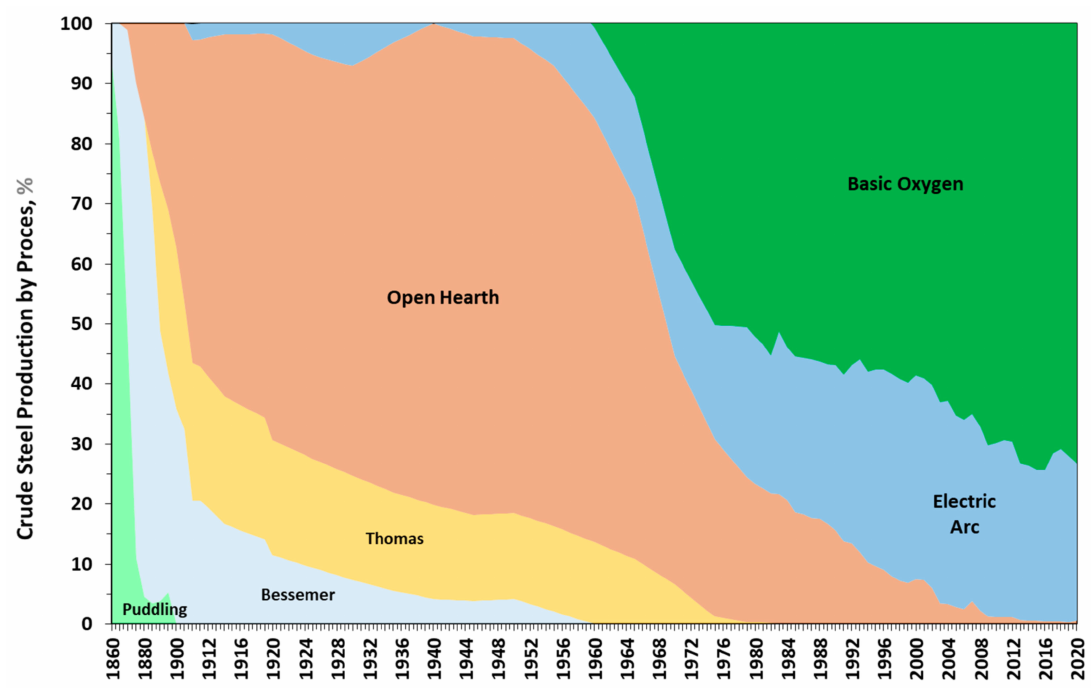
Figure 3. Development of the world steel production and the share of steelmaking technologies since 1860